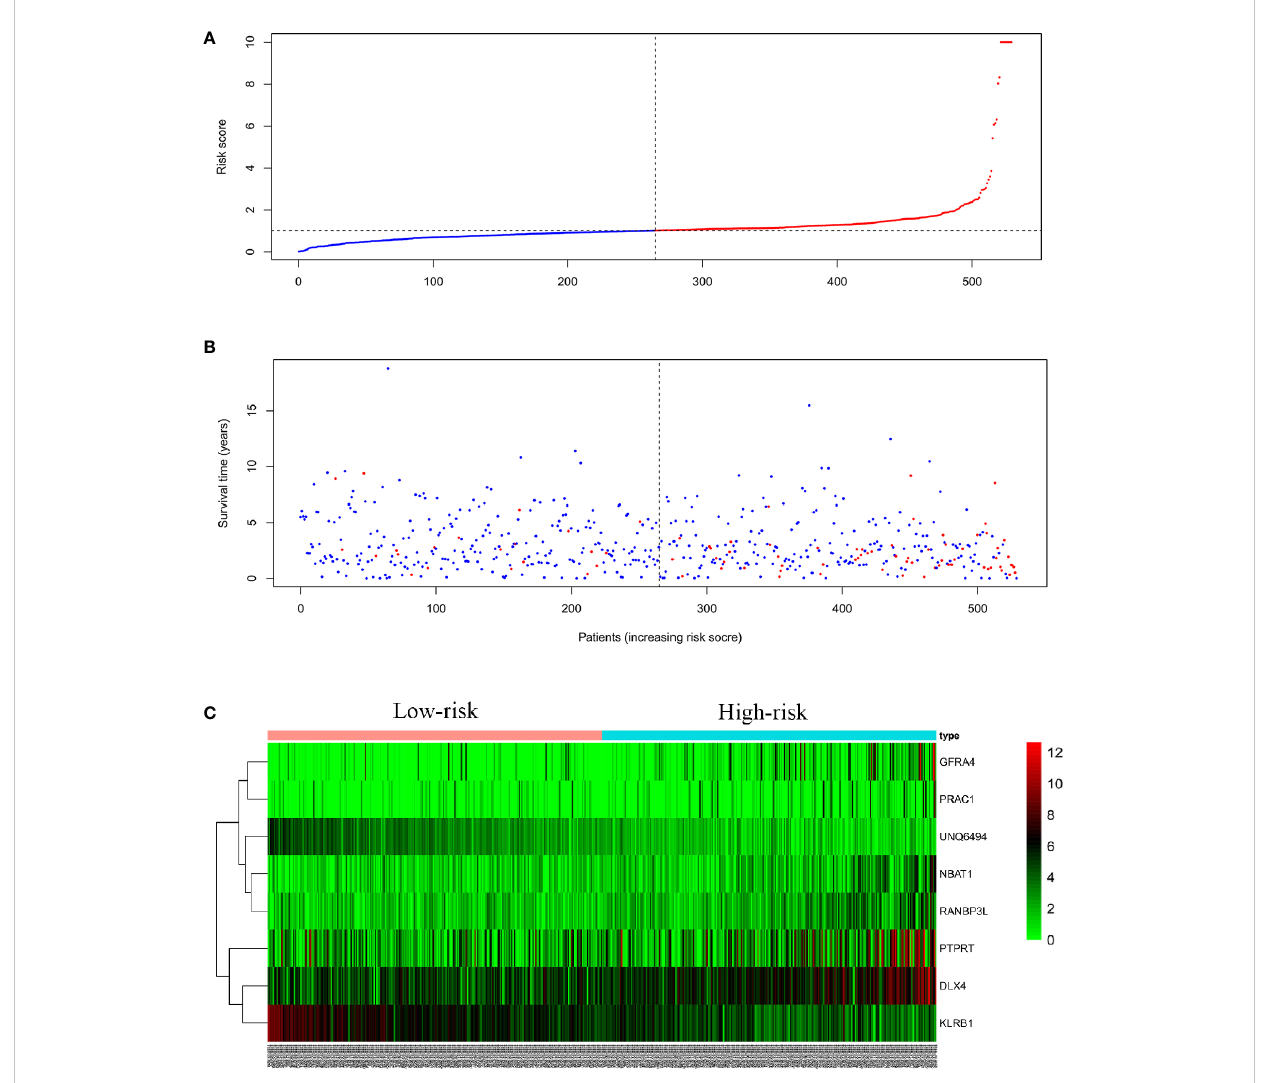
FIGURE 5 Eight mRNA signatures related to riskScore predict OS in endometrial cancer patients (A) Distribution of mRNA riskScore for each patient (the red line represents high risk, the blue line represents low risk) (B) Survival time (years) of EC patients in ascending order of riskScore (the red dots represent dead patients, the blue dots represent surviving patients) (C) A heatmap of eight genes expression pro fi